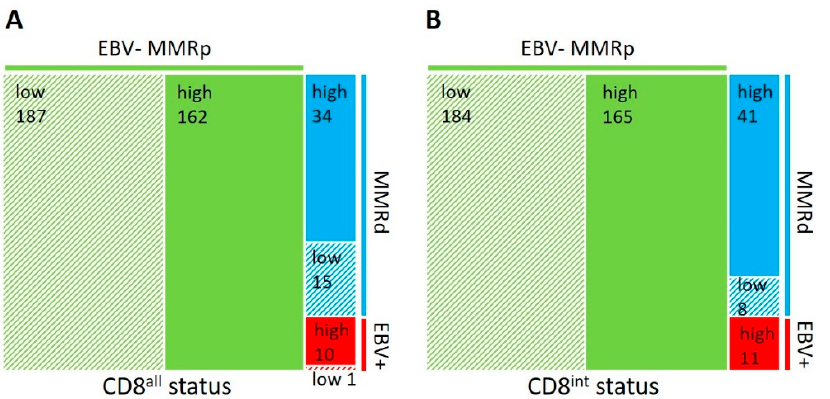
Figure 2. Correlation of tumor-infiltrating CD8+ lymphocytes with EBV and MMR status. Area proportional tree maps are shown based on the number of all (intra- and peritumoral) CD8+ lympho- cytes (CD8 all ) ( A ) or intratumoral CD8+ lymphocytes (CD8 int ) ( B ) per TMA core. Note the increased association of the CD8 int high status with the EBV+ and MMRd subtypes in comparison to the CD8 all status.